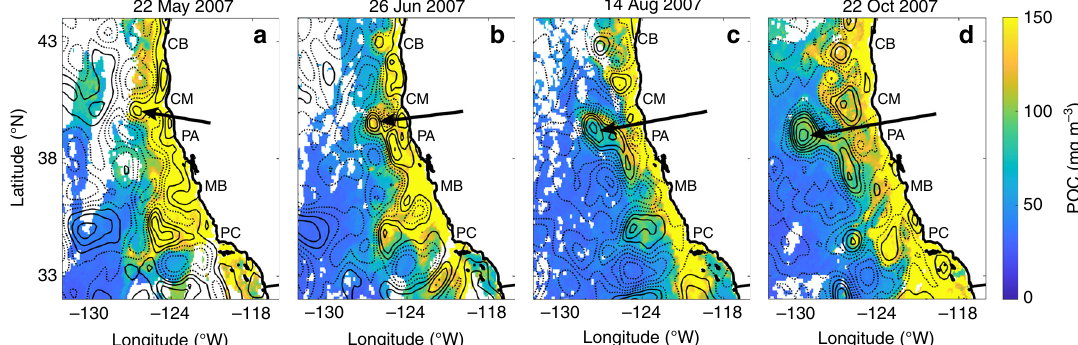
Fig. 1 Example of offshore transport by an eddy in the California Current System. Particulate organic carbon (mg m − 3 ) derived from satellite observations and mean sea-level anomaly contours from altimetry at 4-cm intervals on a 22 May 2007, b 26 June 2007, c 14 August 2007, and d 22 October 2007. Solid contours are negative. Arrows mark the location of a cyclonic eddy transporting coastal water rich in carbon offshore. CB Cape Blanco, CM Cape Mendocino, PA Point Arena, MB Monterey Bay, PC Point